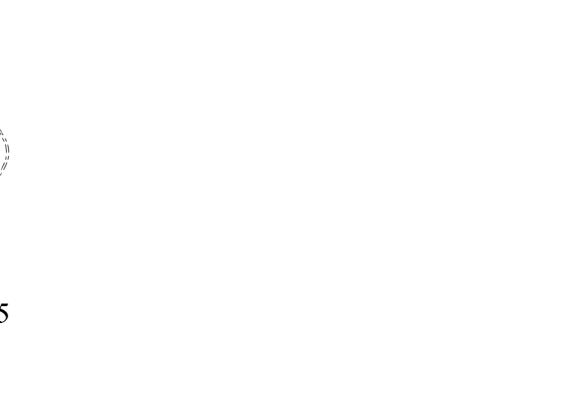
5 of 22 Figure 3. A schematic diagram of the hook and tooth assembly structure: 1. Limit short shaft; 2. Guide side plate; 3. Roller; 4. Hook tooth mounting shaft; 5. Hook tooth; 6. Threaded fastener. In Figure 2, the chain rake frame structure characteristics can be seen. In picking up film teeth movement to the nearest position, direction changing chute will top up the